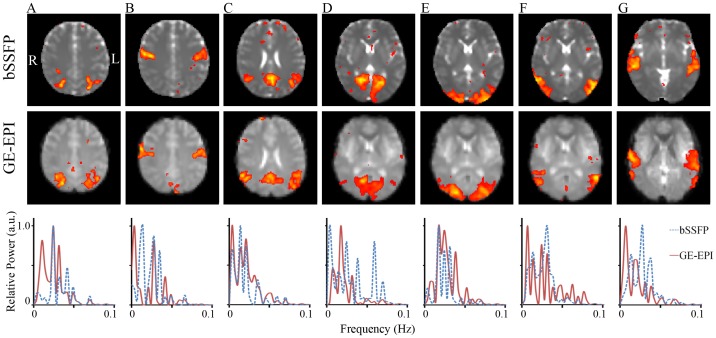
Resting-state networks (RSNs) of human derived from bSSFP and GE-EPI images.RSNs identified representing dorsal attention, primary motor cortex, posterior part of default mode network, occipital visual cortex (VC), medial VC, lateral VC and auditory cortex (A–G) using independent component analysis. bSSFP and GE-EPI images were acquired from the same subject with identical temporal resolution, spatial geometry and resting-state paradigm. Power spectra, converted from time courses of corresponding independent components using Fast Fourier Transform, clearly indicate low frequency dominance. Z-maps were thresholded using histogram mixture modeling at an alternative hypothesis threshold P>0.5.